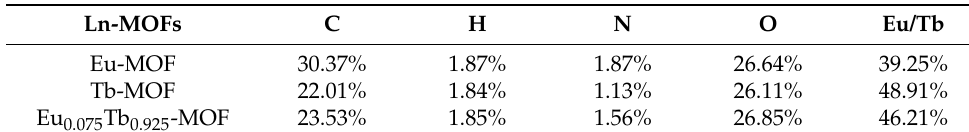
Table 1. Element analysis table.